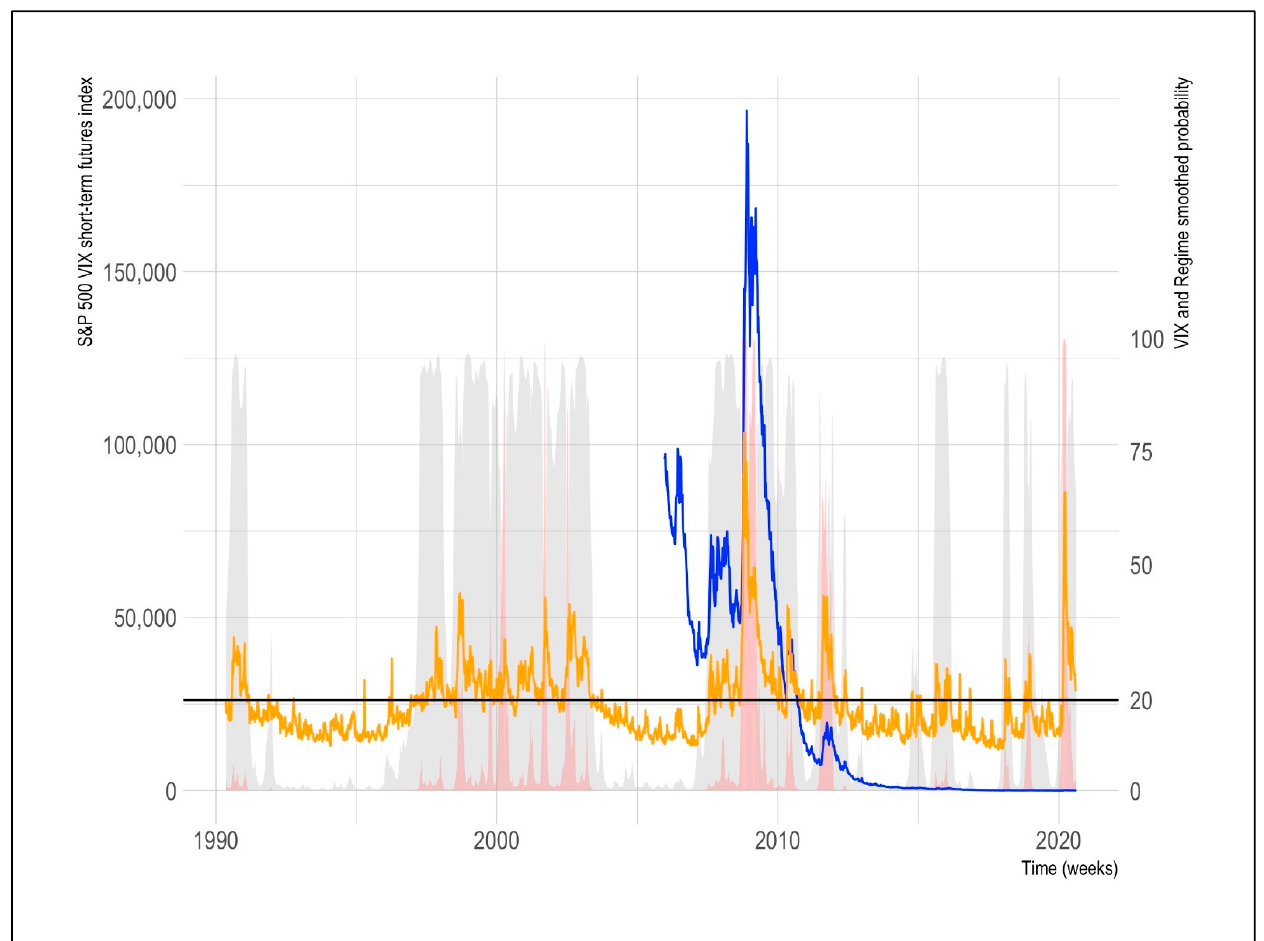
Figure 2. The historical performance of the S&P 500 VIX short-term futures and VIX indexes. Color codes: The S&P 500 is depicted with a blue line, the VIX index with an orange one, the high volatility regime probability at t is the grey area and the “extreme” volatility regime is the red one. Source: Own elaboration with data from Refinitiv [16].